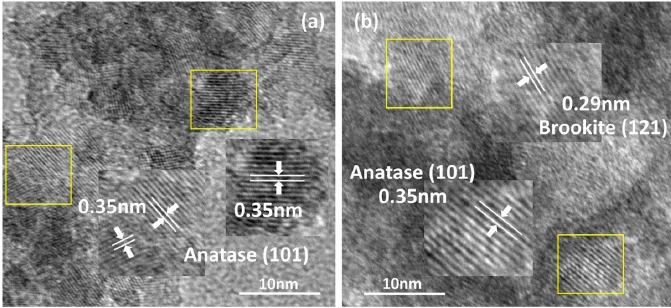
Figure 2. High ‐ resolution TEM (HRTEM) images of NA ‐ 165. The lattice fringes of 0.35 nm and 0.29 nm match ( a ) the anatase (101) and ( b ) brookite (121) plane.